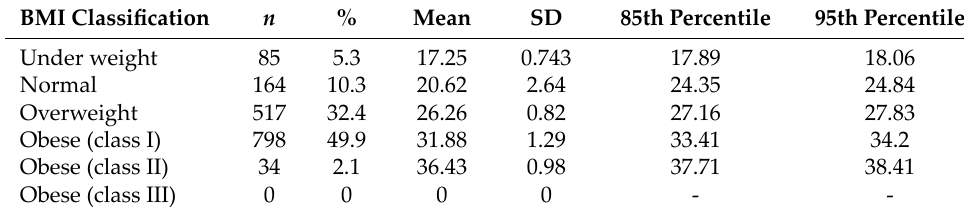
Table 2. Body mass index classification among the sample of the